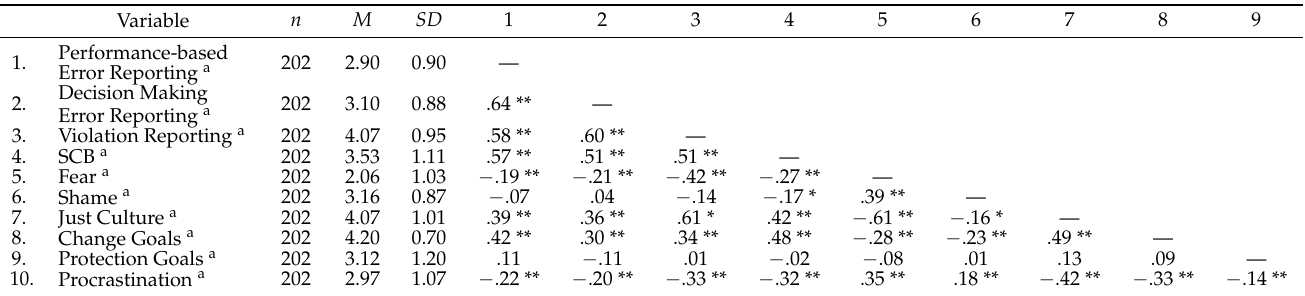
Table 1. Descriptive statistics and correlations for study variables.